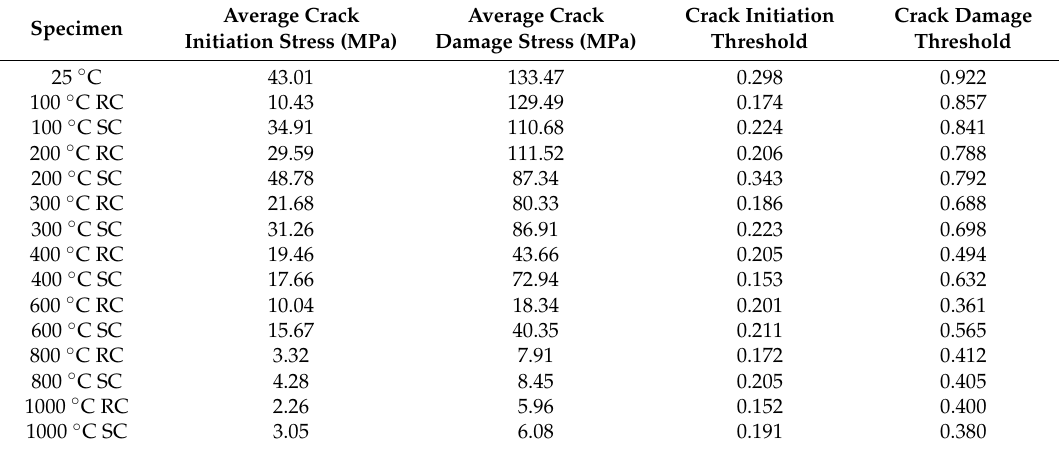
Figure 10. Change of crack initiation and crack damage thresholds over increase of pre-heating temperature under rapid cooling treatment and slow cooling treatment. Table 4. Average values for stresses at crack initiation and crack damage